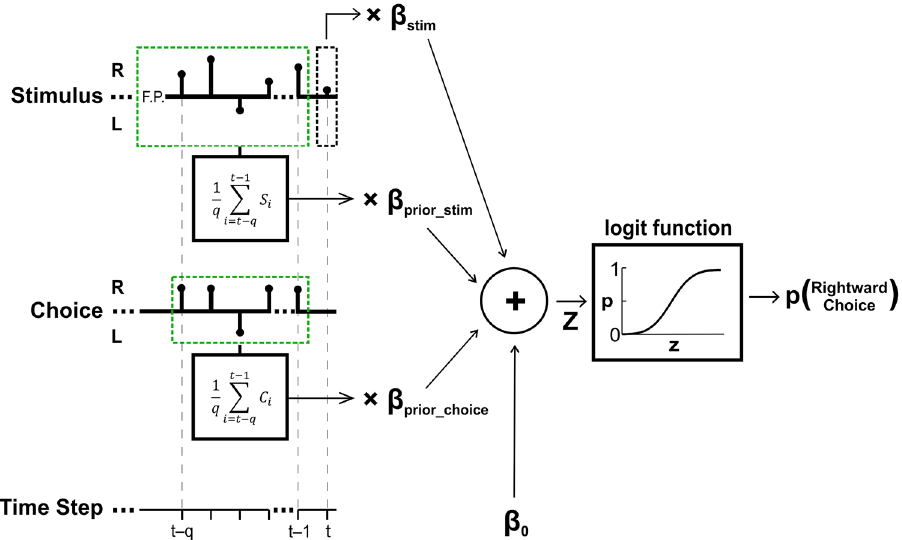
Figure 2. Perceptual decision model schematic. A logistic regression was used to model location discrimination choices based on four predictors (and their respective fitted beta coefficients): (1) current stimulus location (β stim ), (2) stimulus location history (β prior_stim ), (3) choice history (β prior_choice ) and (4) baseline bias (β 0 ). Black stems on the stimulus and choice axes mark stimulus ( S i ) and choice ( C i ) at time step i for an example trial, with test stimulus at t (black dashed box), and prior stimuli and choices q steps back (for example, priors biased to the right, green dashed boxes). The trial began with a central fixation-point ( F.P. ). The sum of the product of the predictors with their respective coefficients ( z ) is passed through a logistic function to yield the probability of making a rightward choice in response to the test